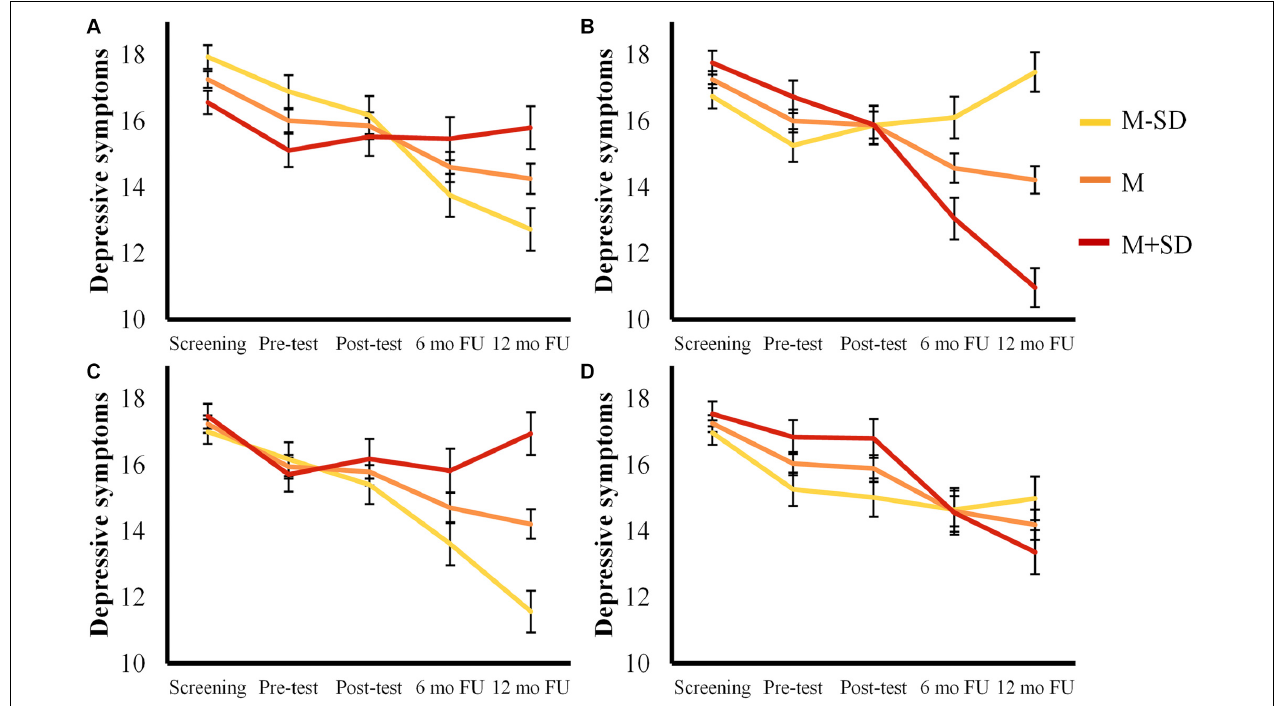
FIGURE 5 | Estimated mean trajectories for depressive symptoms moderated by (A) Rejection Sensitivity, (B) Hope and Optimism, (C) Rumination and, (D) Distraction and Problem solving. Error bars represent standard